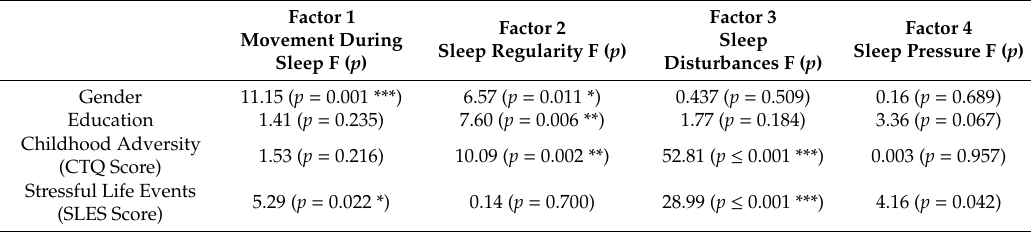
Table 3. Childhood trauma and stressful life events e ff ects on sleep patterns